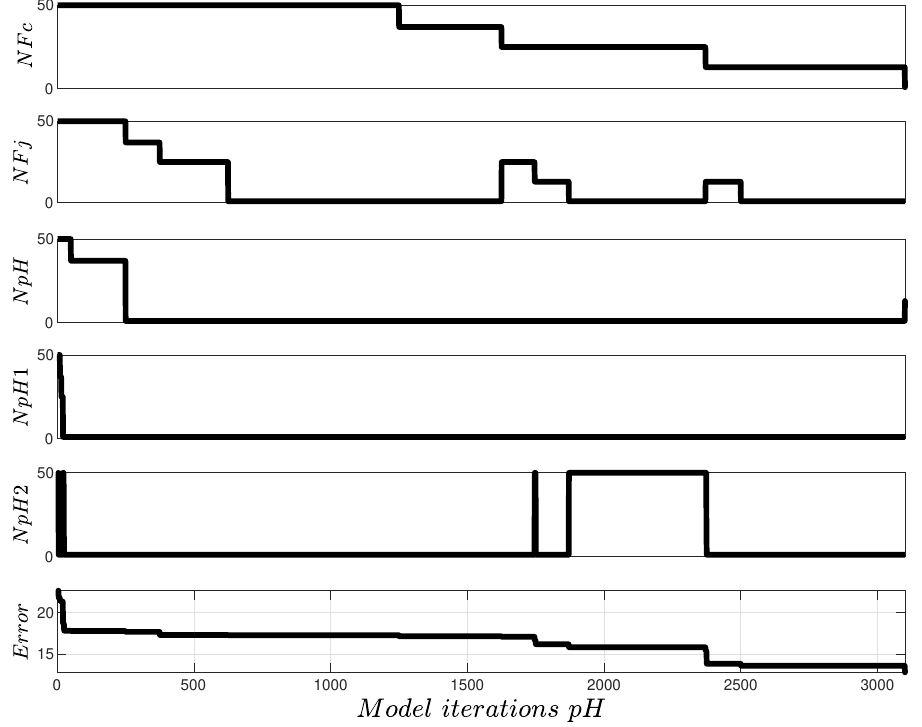
Figure 7. Evolution of regressor parameters pH, F C , F J , pH 1 , pH 2 with the algorithm